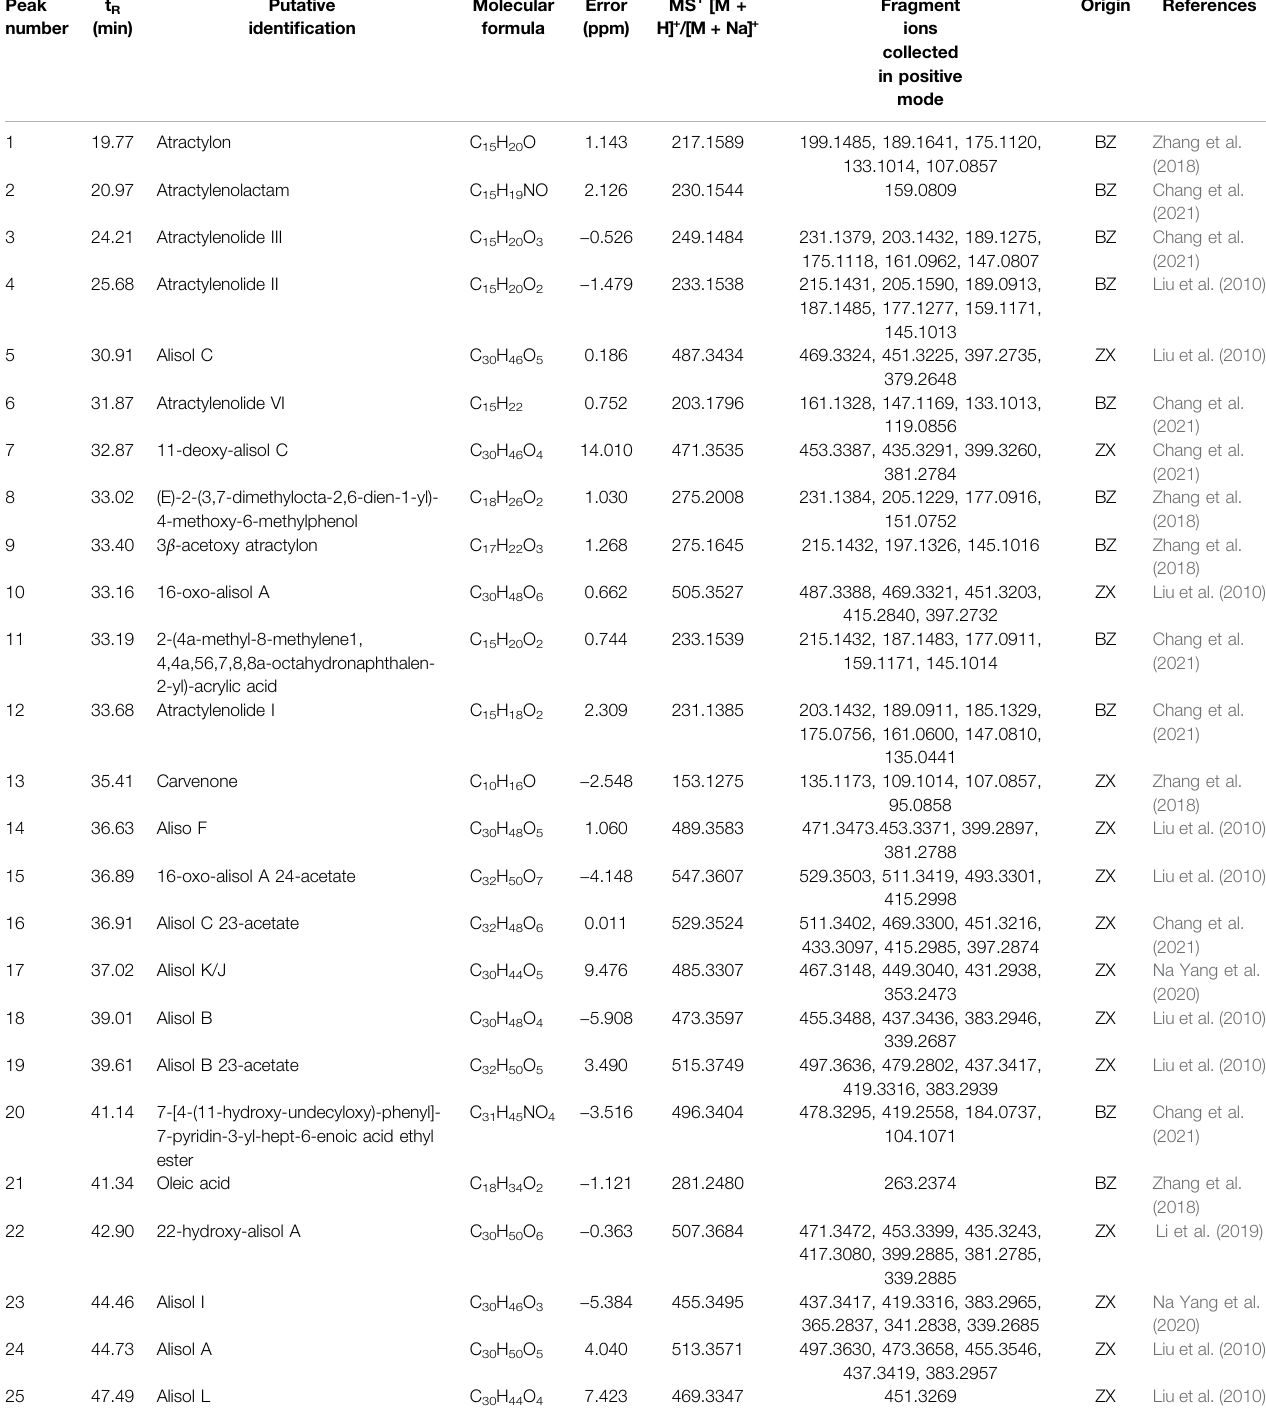
TABLE 6 | The putatively identi fi ed chemical constituents in drug-containing plasma by UHPLC-QE-Orbitrap-MS . Peak